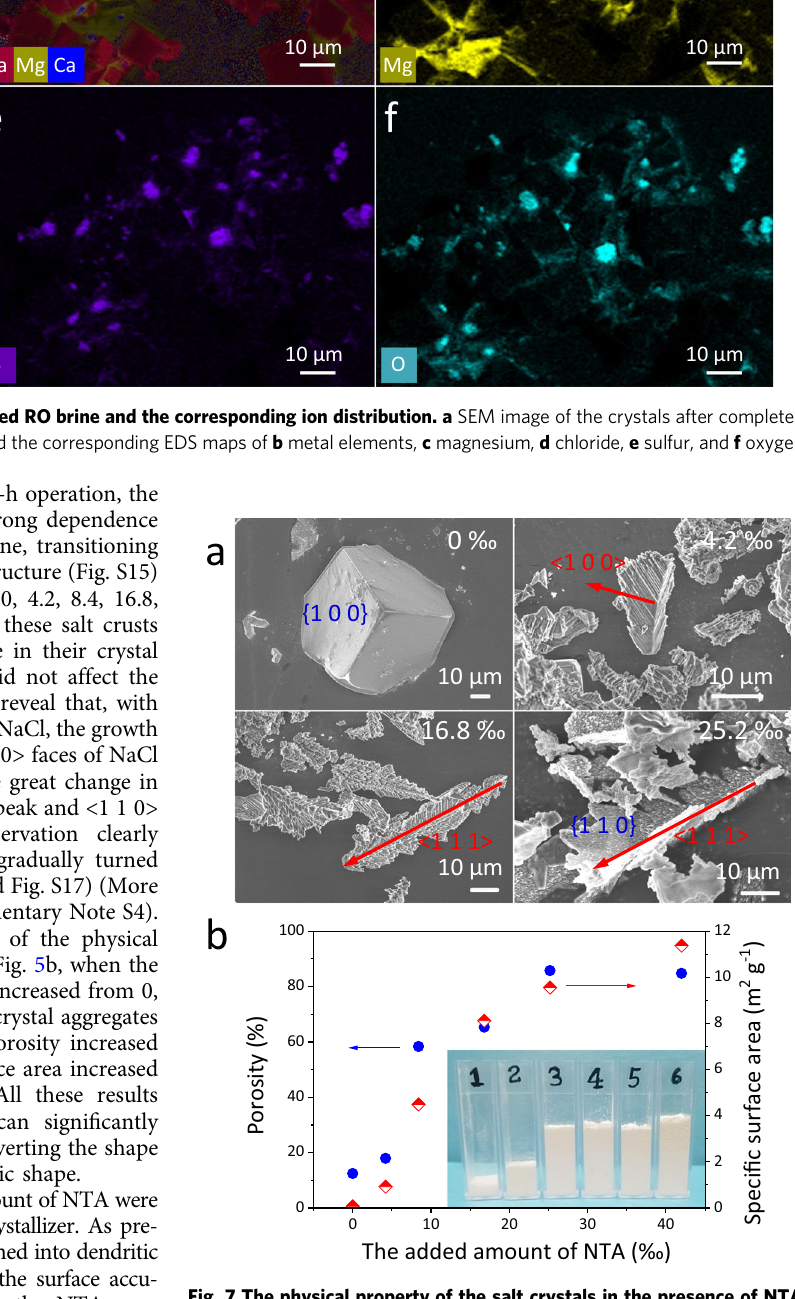
Fig. 7 The physical property of the salt crystals in the presence of NTA. a The SEM images of the salt crystals in the presence of NTA; b the porosity and surface area of each salt samples; inset photo shows 0.4 g collected salt crystals formed from 12 wt% NaCl brine with (1) 0 ‰ , (2) 4.2 ‰ , (3) 8.4 ‰ , (4) 16.8 ‰ , (5) 25.2 ‰ and (6) 42.0 ‰ NTA in cuvette (the bottom side length: 10